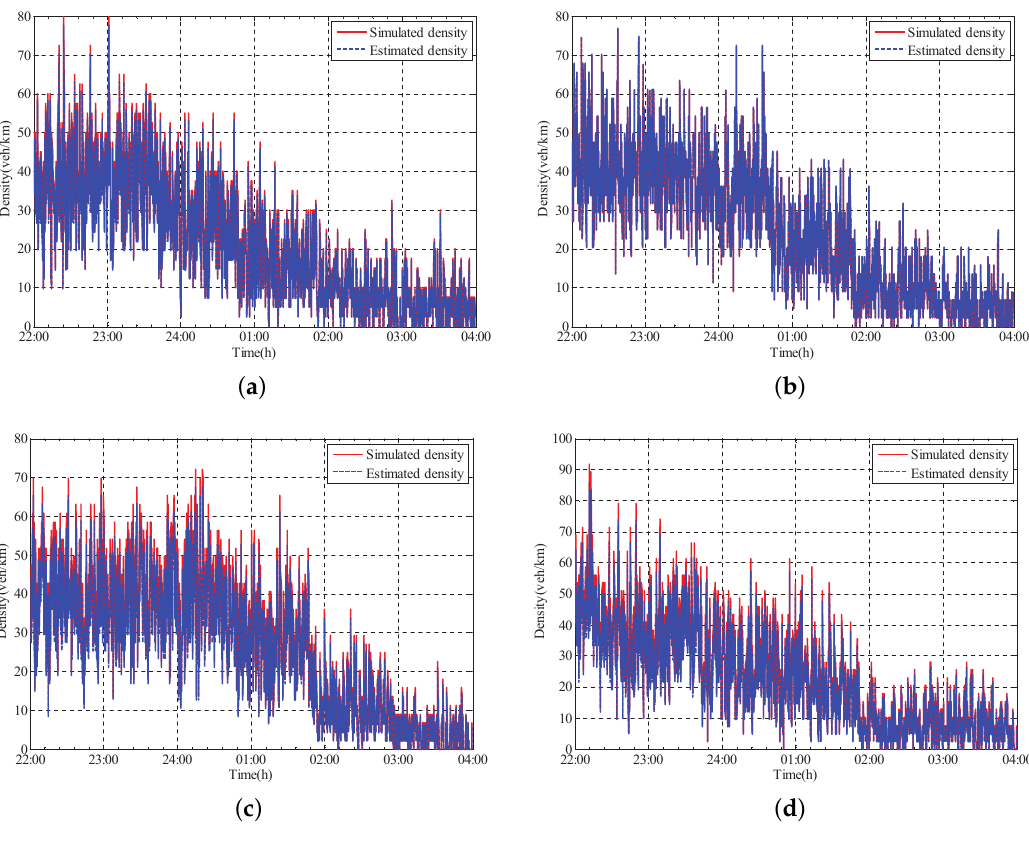
Figure 5. Experimental results. ( a ) Cell 6; ( b ) Cell 41; ( c ) Cell 70; ( d ) Cell